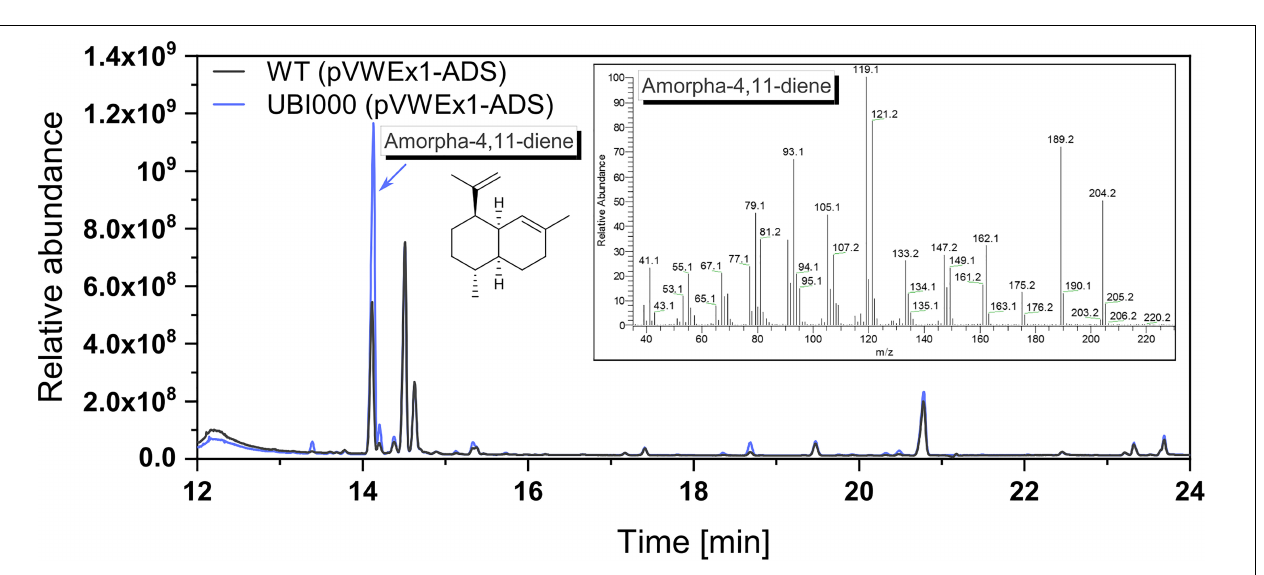
FIGURE 3 | Production of amorphadiene as a means to quantify FPP supply. The extracts of dodecane overlay cultivation with WT (pVWEx1-ADS), shown in black, and UBI000 (pVWEx1-ADS), shown in blue, were analyzed via GC-MS. For quantification, valencene was used as a standard equivalent. Shown are the chromatogram and in the insert the mass spectrum of produced